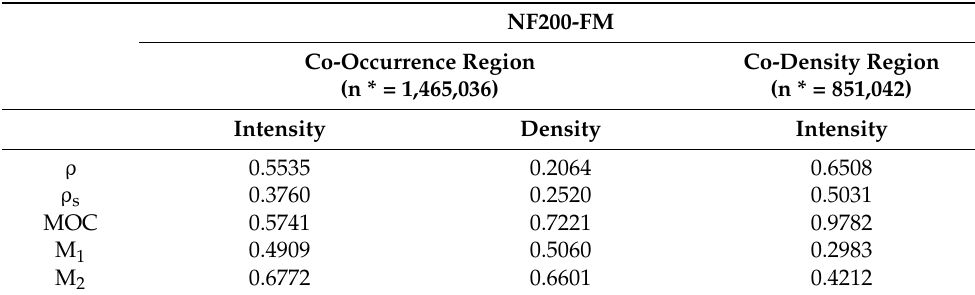
Table 3. Comparison between NF200 and FM intensity and local density colocalization analysis, before and after refinement for local